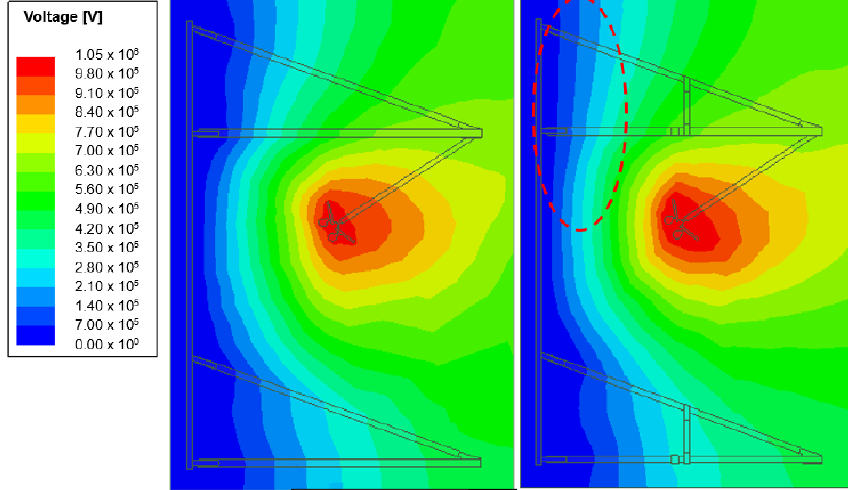
Figure 10. Equal-potential distribution in the case of a 57° pivoted insulator.